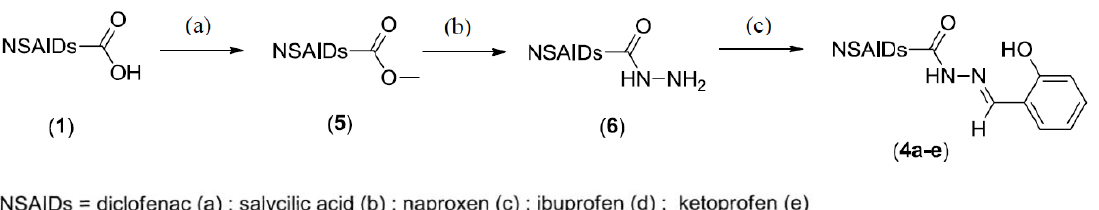
Figure 2. Preparation of compounds 4a – e . Reagents and conditions: (a) CH (95%–99%); (b) NH H + ,